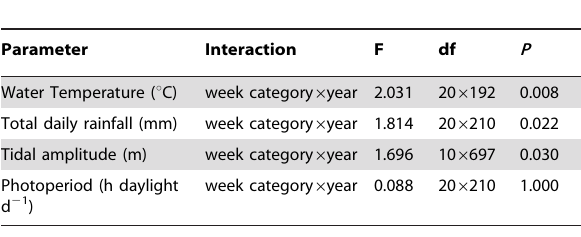
Table 1. ANOVA results for the variation in parameters potentially associated with metamorphosis.